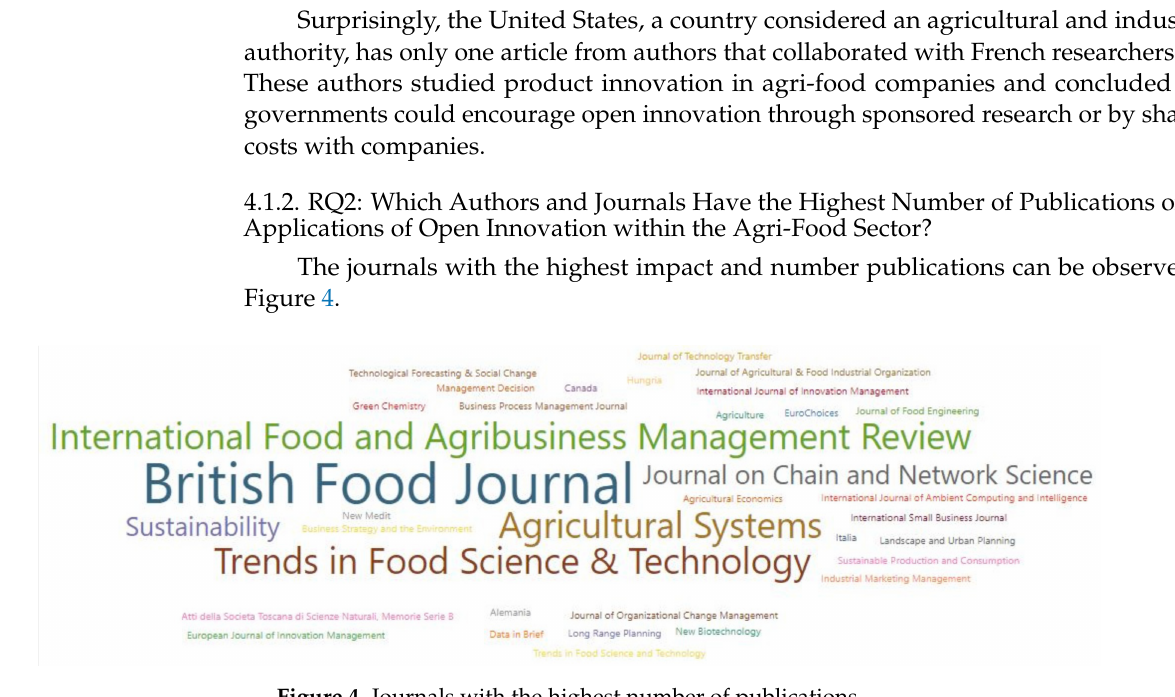
Figure 4. Journals with the highest number of publications.